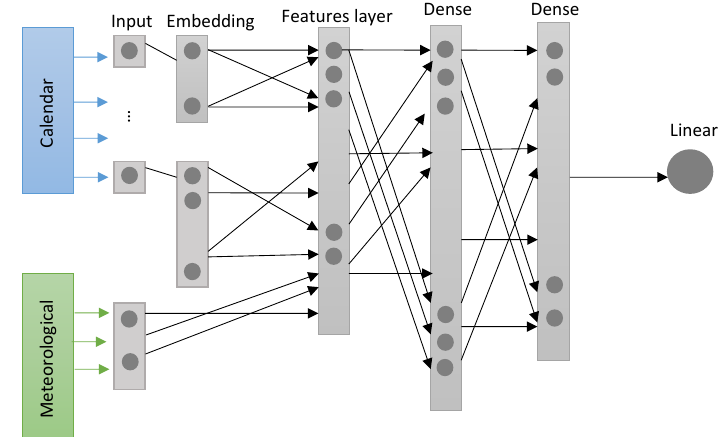
Figure 9. General scheme for DNN with an embedding